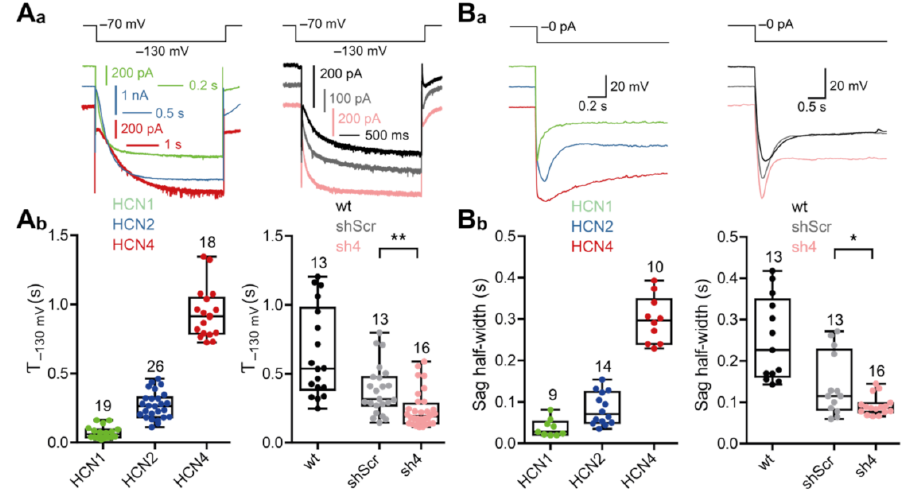
Figure 6. Knock-down of HCN-channel subunit 4 speeds up the inward rectification (sag) and I h . ( A a ) Representative current traces of whole-cell patch-clamp recordings from − 130 mV current pulses of HEK293 cell lines (left) and wildtype (wt) or sh4-/shScr-transduced primary hippocampal neurons (PHNs; right). ( A b ) Time constants of monoexponential fits from the current responses of the HEK293 cell-lines (left) and wt or sh4-/shScr-transduced PHNs (right). ( B a ) Representative voltage traces of whole-cell patch-clamp recordings from current pulses which hyperpolarize the membrane potential to − 130 mV of HEK293 cells stably expressing HCN-channel subunit 1, 2, or 4 (left) and wt or rAAV9-transduced eGFP-positive PHNs (right). ( B b ) Sag half-width of HEK293 cell-lines (left) and wildtype or transduced PHNs (right). Results are depicted as boxplots. Statistical significance was assessed using the unpaired two-tailed Student’s t test, * p < 0.05, ** p <